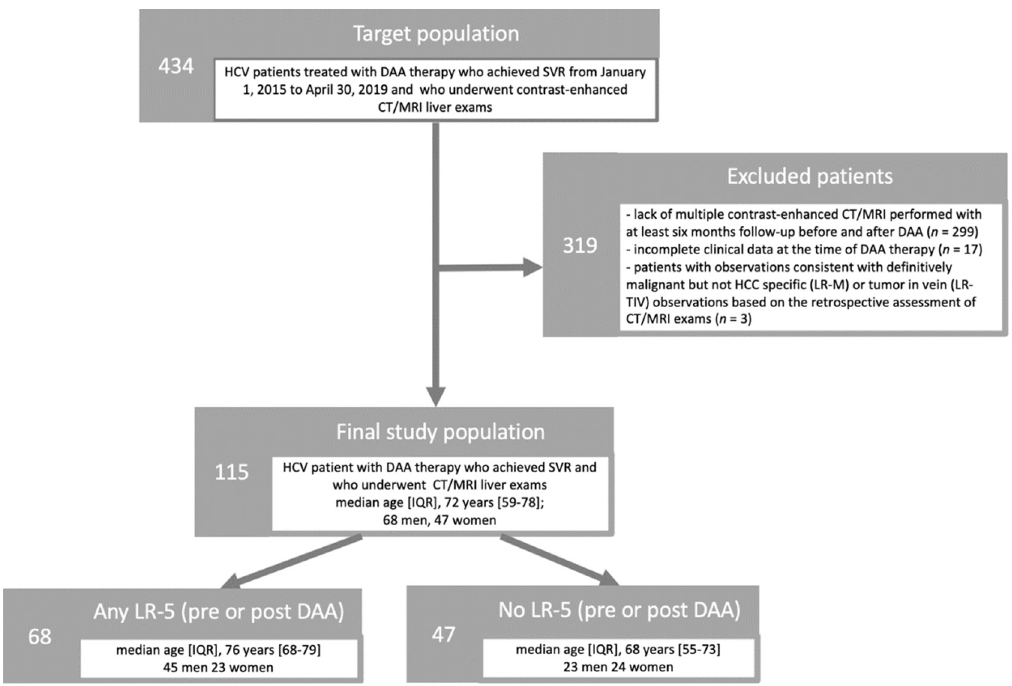
Figure 1. Flowchart of the study populations following the Strengthening the Reporting of Obser- vational Studies in Epidemiology initiative.